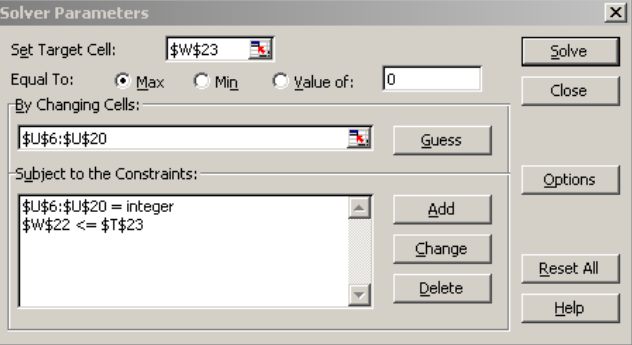
Figure 4: Solver setup for spreadsheet implementation of